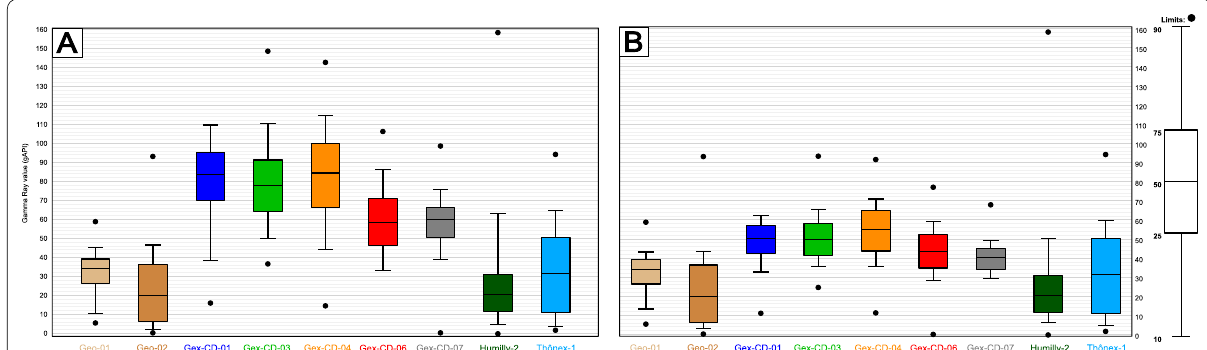
Fig. 2 Box plots of GR values before ( A ) and after ( B ) normalization. Middle line in box plots depicts mean values, circles denote extreme values (outliers). The latest geothermal exploration wells (Geo-01, Geo-02, Thônex-1) were used as calibration for older, hydrocarbon exploration wells (Gex-CD-01, -03, -04, -06, -07 and Humilly-2) to homogenize the